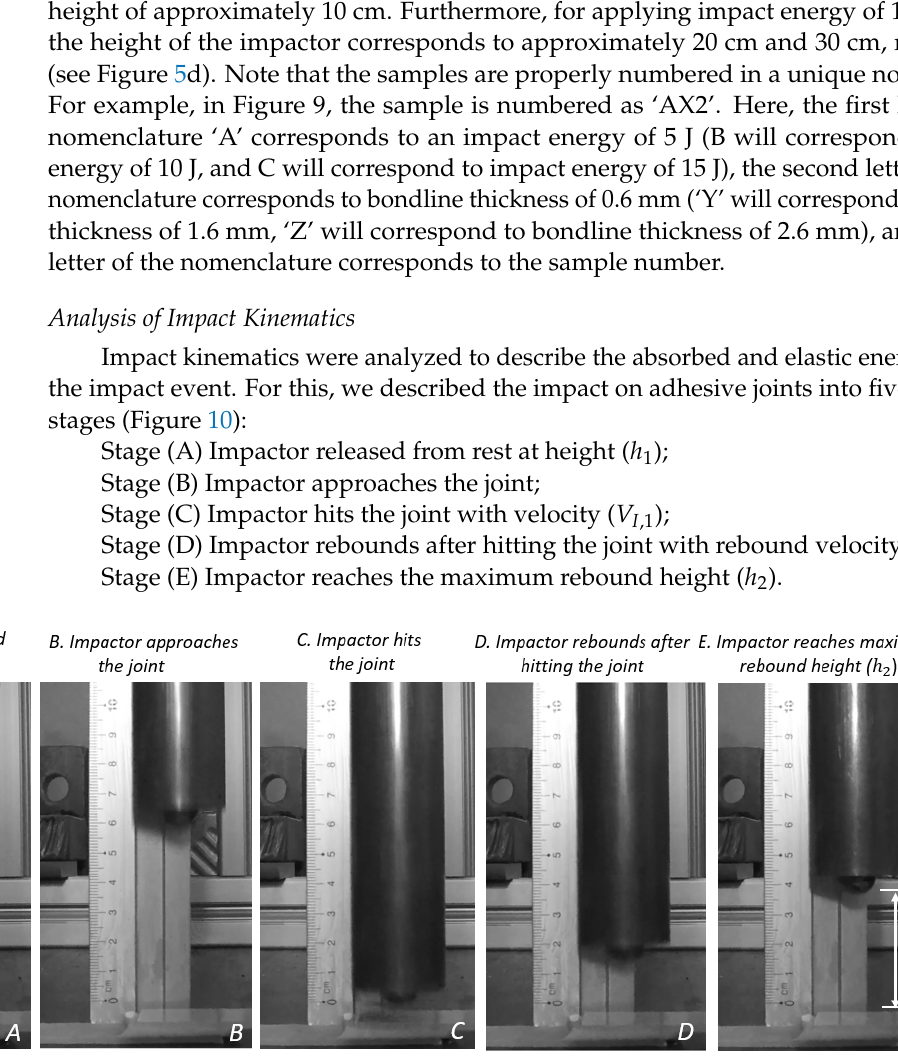
Figure 10. Different stages of impact event recorded by